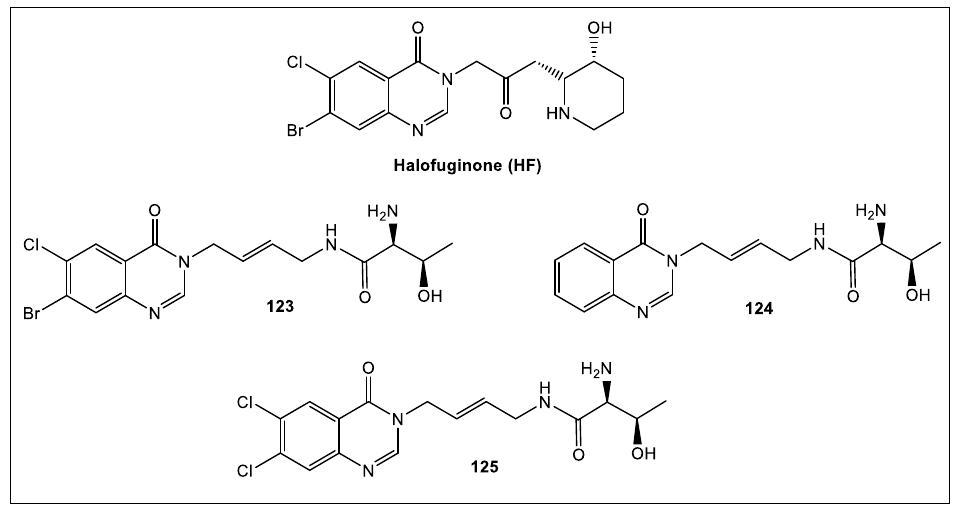
Figure 23. Halofuginone (HF), an inhibitor of the plant analog of ThrRS, the prolyl-tRNA synthetase (ProRS). Fragments 123 and 124 are the best representatives of a series of synthetic analogs of HF. Compound 125 demonstrated antibacterial activity (MIC 16 mg/mL) against E. coli and Salmonella enterica [115].